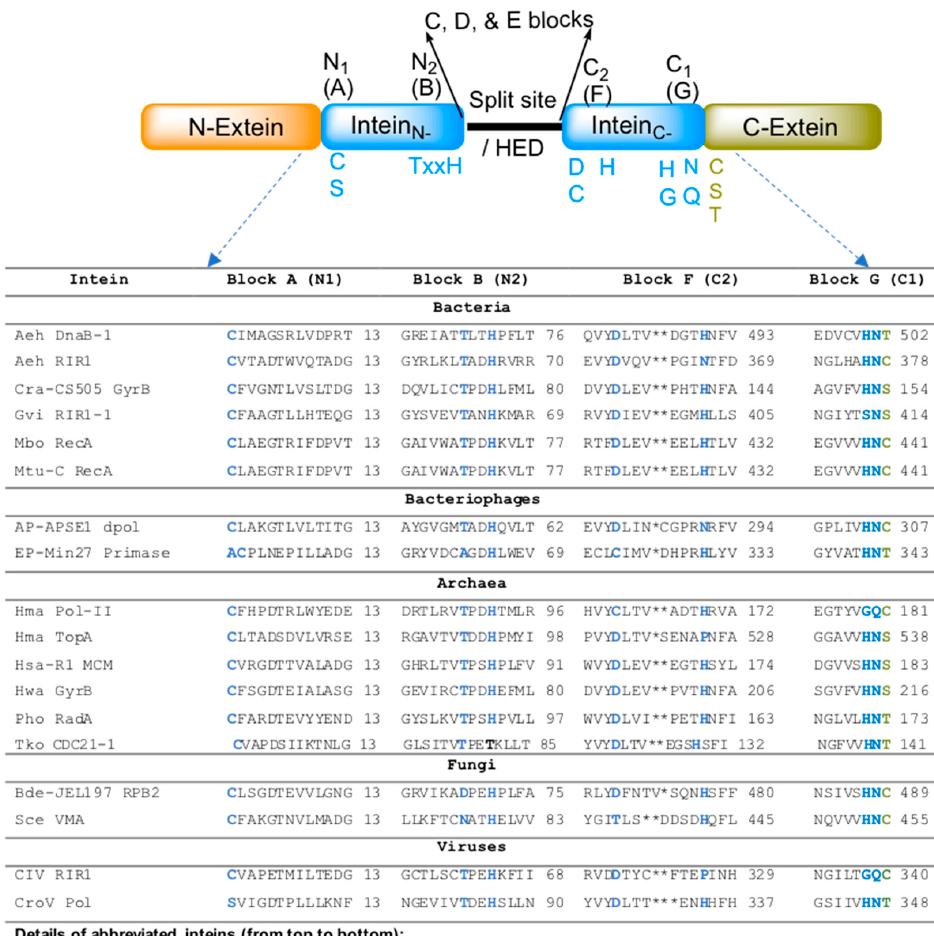
Figure 3. Important motifs and conserved splicing elements of inteins. Inteins contain four important motifs: The N-terminal region with N 1 and N 2 ; and the C-terminal region with C 1 and C 2 motifs. The important splicing amino acid residues of each motif are indicated. The conserved amino acid residues (C, S, and T) on the C-extein are also indicated. These amino acids are also important for the splicing process to occur. A list of selected intein-associated proteins of bacteria, bacteriophages, viruses, and fungi, and their protein sequence alignment of conserved A, B, E, and F motifs, is also given.